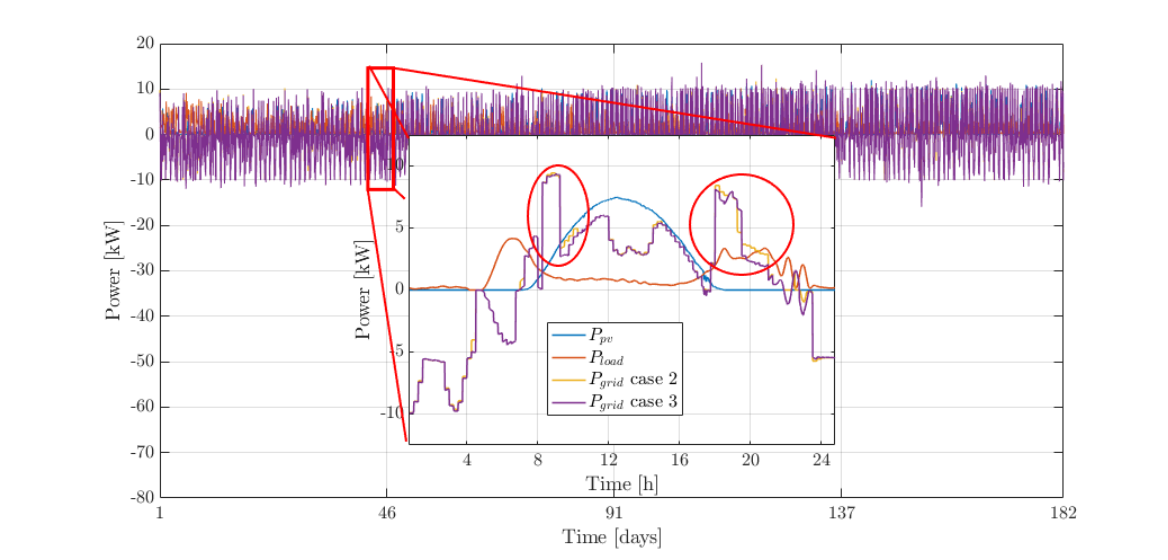
Figure 12. Comparison of grid powers for case 2 and case 3 (with and without real-time